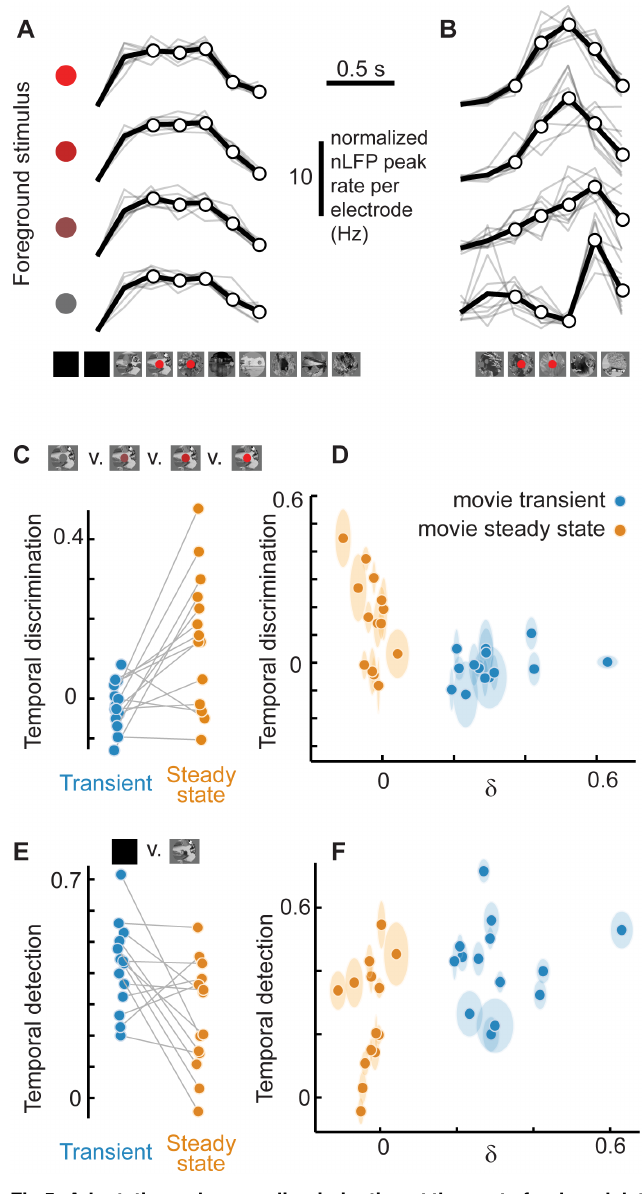
Fig 5. Adaptation enhances discrimination at the cost of reduced detection: Temporal coding. ( A ) The time course of populationresponseduringthe 1 s (0.2 s resolution) followingthe four different foreground stimuli (red dots) showedlittle difference duringthe transient response. Black lines indicateresponse averaged over repeatedtrials. Gray lines indicate individual trials. Each responsewas subtracted by its time averageand normalizedby its variancesto emphasize effects of rate coding.One example turtle shown. White dots indicatethe 5 bins used to compute the 5 bit temporalresponse. (B) During the steady-state, different foregroundstimuli evoked differing temporalstructure of responses. Thus, temporal structure carries useful informationfor discrimination. (C) Summary of discrimination basedon temporal structure for 14 experiments. Most turtles showedan increasein discrimination from transient to steady-state. (D) Variability in discrimination is better explainedwhen changesin δ are accountedfor. Similar to rate-baseddiscrimination, power-law distributed (low δ ) populationdynamicsare associatedwith optimal temporaldiscrimination. (E) Summary of detection basedon temporal structure for 14 experiments. Detection typically decreased from transient to steady-state. (F) Variabilityin detectionis better explainedwhen changesin δ are accountedfor. Similar to rate-based detection, power-lawdistributed(low δ ) population dynamics are associatedwith low detection.